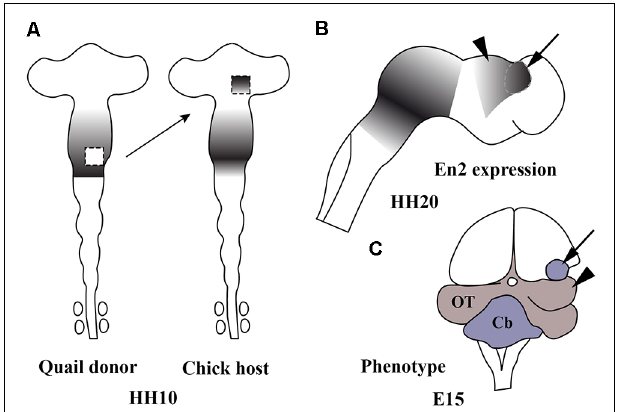
FIGURE 6 | Schematic representation of chick/quail chimeric experiments showing the ectopic induction of En2 in the alar plate of the caudal diencephalon of chick (host; A ) when the isthmocerebellar primordium of quail (donor; A ), expressing high levels of En2, was grafted into it at stage HH10 (Martinez et al., 1991). The En2-expressing area is represented by gray areas. At stage HH20 (B) , the quail graft (arrow) maintains its original En2 expression and induces an inverted gradient of En2 expression within the caudal prosencephalon (arrowhead), typical of the mesencephalic vesicle. A long-survival analysis performed at El5 (C) shows that the graft (arrow) developed a small cerebellum and the En2-induced host primordium changed its fate for an ectopic mesencephalon (arrowhead). Cb, cerebellum; OT, optic tectum. From Alvarado-Mallart